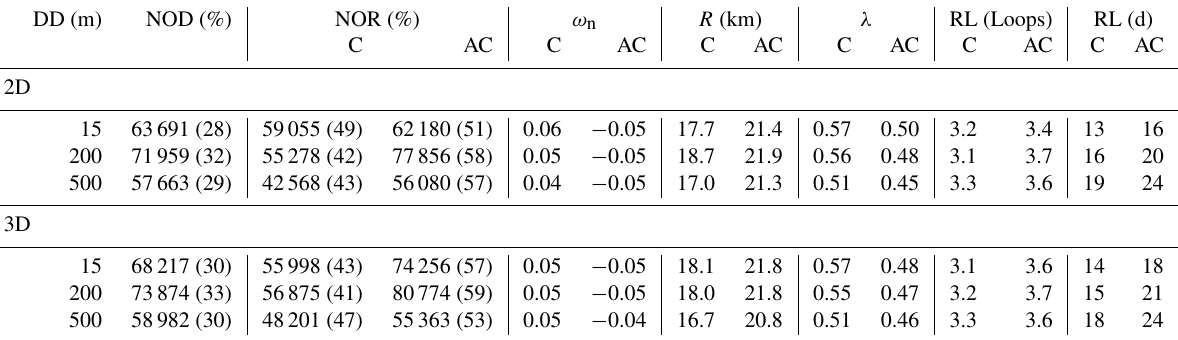
Table 2. Statistics for drifters in 2D and 3D simulations containing ridges, showing the number of drifters (NODs) that contained ridges with corresponding percentages in parentheses of total drifters studied for the given deployment depth (DD; 15m = 225732; 200m = 224016; 500m = 195624). As a drifter can experience several ridges, the number of ridges (NORs) is also given, separately for cyclonic and anti- cyclonic ridges together with their percentage in parentheses. The non-dimensional frequency ( ω n ), mean geometric radius ( R ) and ellipse linearity ( λ ) after averaging over all ridge points for the given deployment depth and simulation (2D or 3D) are also given. The ridge length (RL) is listed both as an average of the number of loops exhibited by the drifter containing the ridge and as an average of the number of days the drifters contain